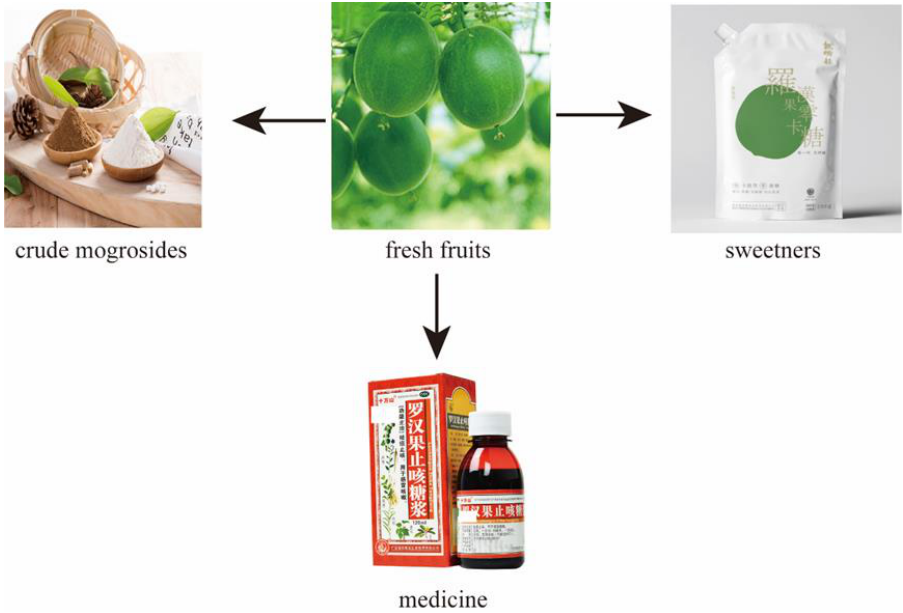
Figure 1. Applications of Siraitia grosvenorii .